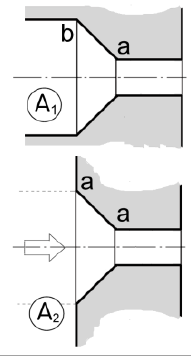
Fig. 4. Fluid is supplied into a nozzle using one of these two inlet configurations: either by the pipe entry A 1 or from the half- space A 2 . The effect of these inlets on nozzle pressure drop is fortunately insignificant. More important are vortices generated at the convex corners “ a ” and concave “ b